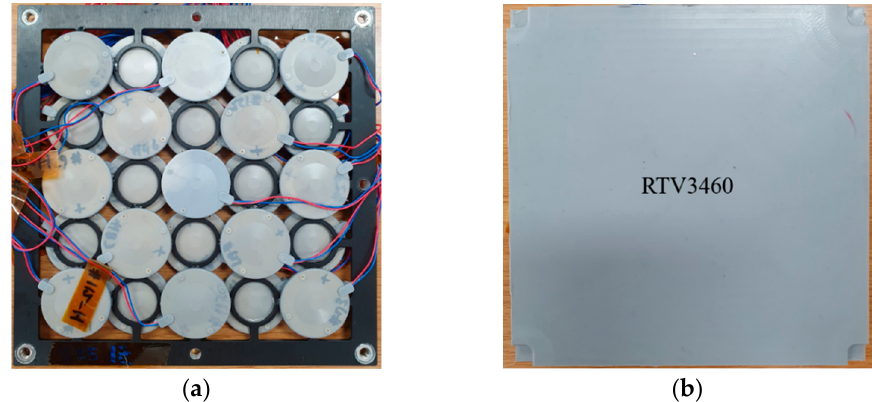
Figure 10. Photograph of the fabricated cymbal array: ( a ) before potting; ( b ) after potting.